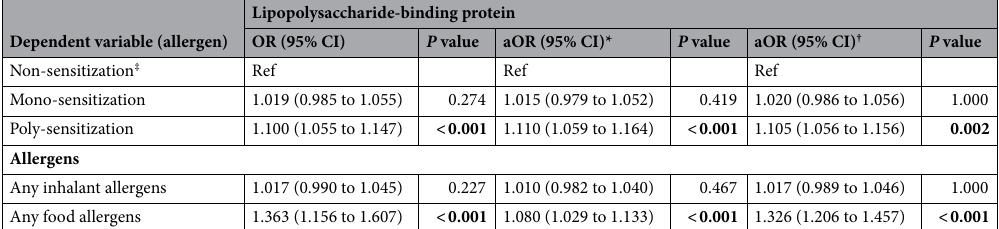
Table 2. Association of serum LBP levelwith sensitization to specific allergens. Allergic sensitization indicates one or more positive reactions (wheal diameter > 3 mm) to any allergen in the SPT. OR odds ratio, aOR adjusted odds ratio, LBP lipopolysaccharide-binding protein. *Multivariate logistic regression adjusted for sex (male), age, body mass index z-score, and household income. † Multivariate logistic regression adjusted for sex (male), age, body mass index z-score, and household income. The Holm method was used to counteract the problem of multiple comparisons. ‡ The P value for the association between LBP level and sensitization (non-, mono, and poly-sensitization) was from multinomial